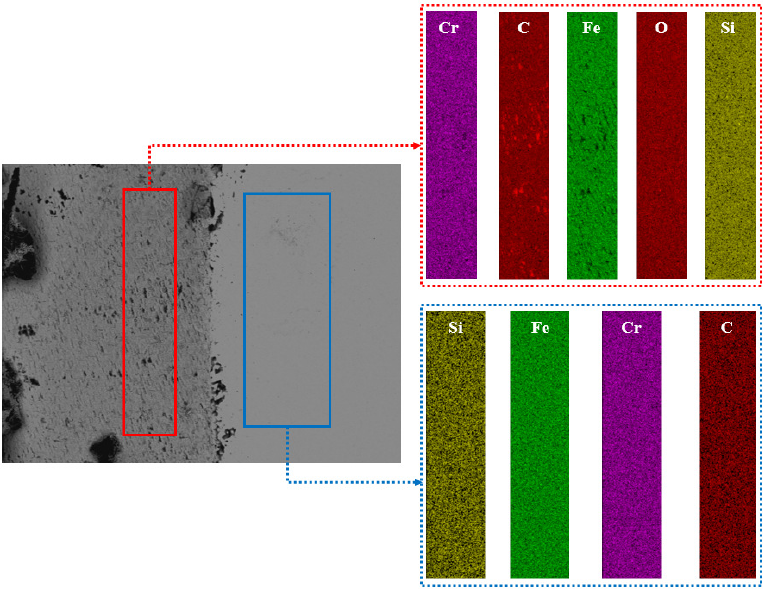
Figure 10. EDS of the front-end bearing’s rolling element wear delamination (serviced).